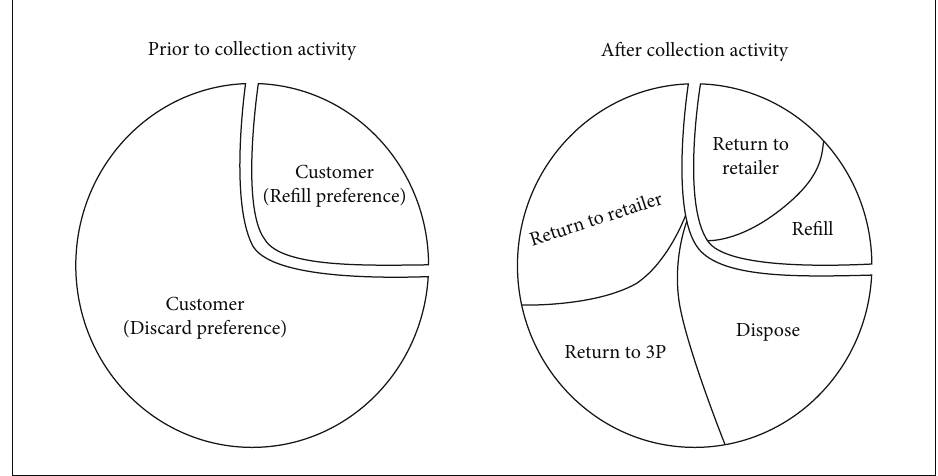
Figure 3: Changes in customer types prior to and after the collection